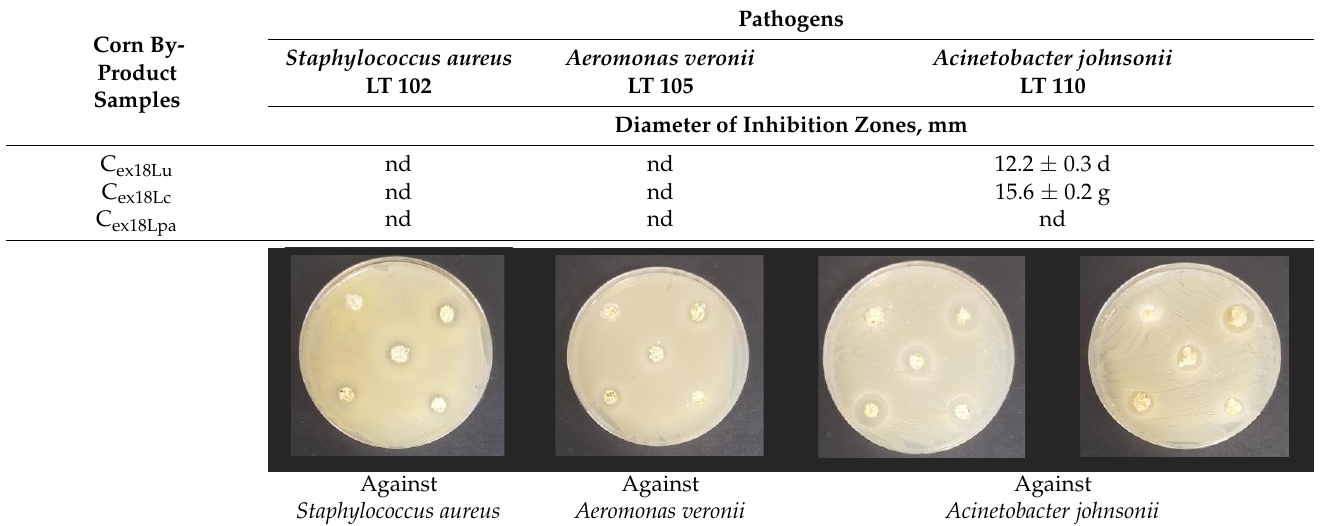
15 of 21 Table 6. Antibacterial properties of non-treated and treated corn by-products.